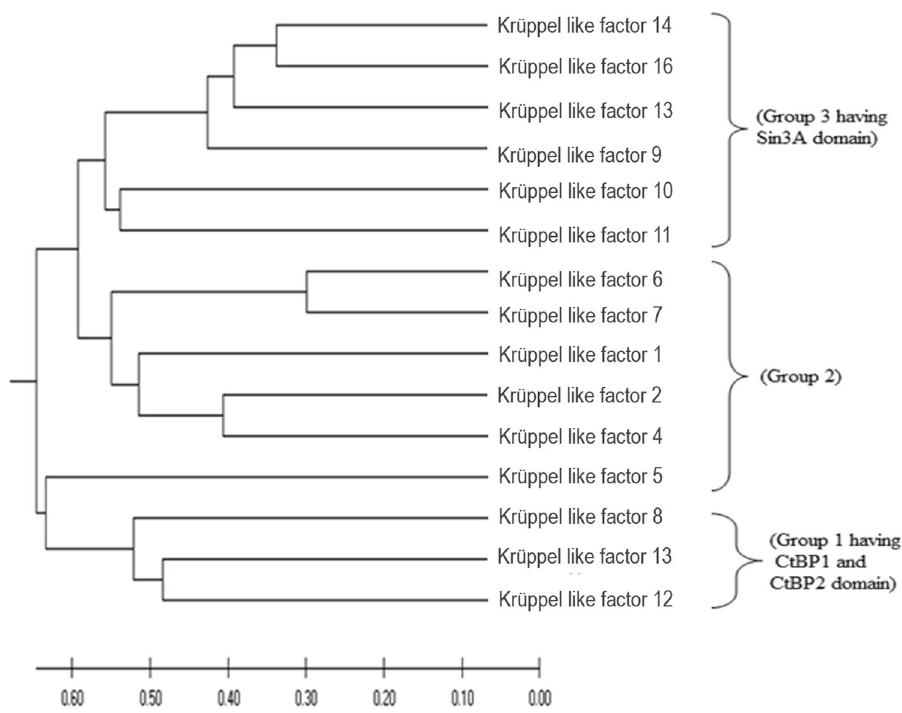
branch lengths in the same units as those of the evolutionary distances used to infer the phylogenetic tree. The evolutionary distances were computed using the Poisson correction method and are in the units of the number of amino acid substitutions per site. This analysis involved 15 amino acid sequences. All ambiguous positions were removed for each sequence pair (pairwise deletion option). There was a total of 602 positions in the final dataset. Evolutionary analyses were conducted in MEGA X 42